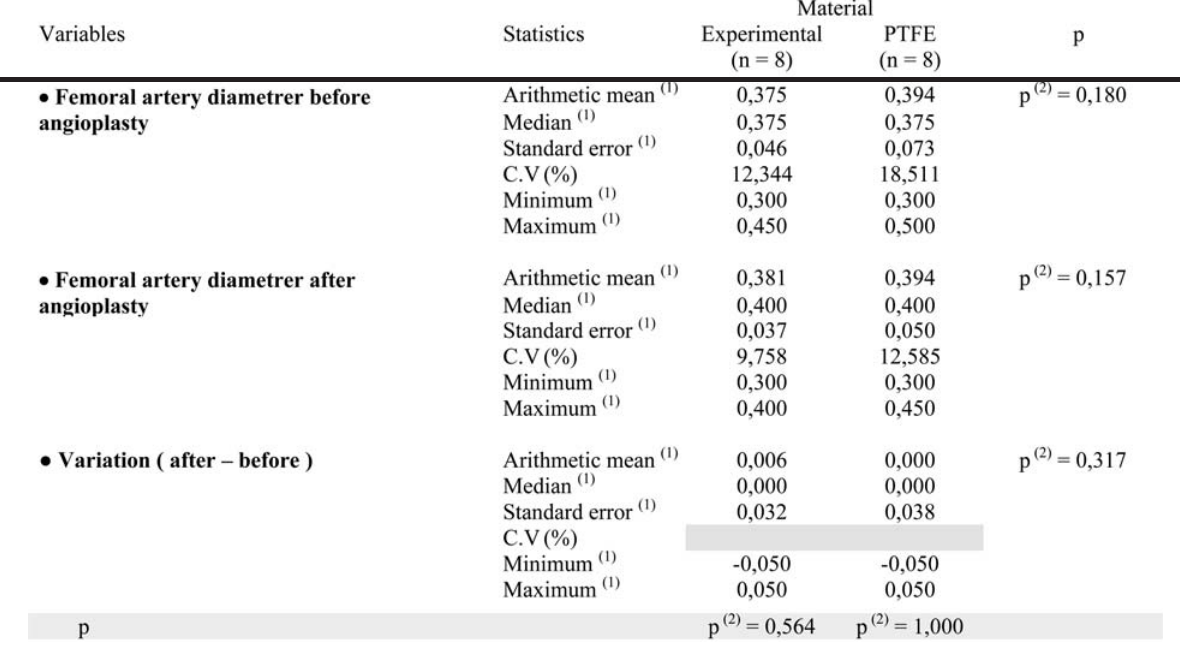
TABLE 1 - Femoral artery diameter before and after the angioplasty, according to the used material.